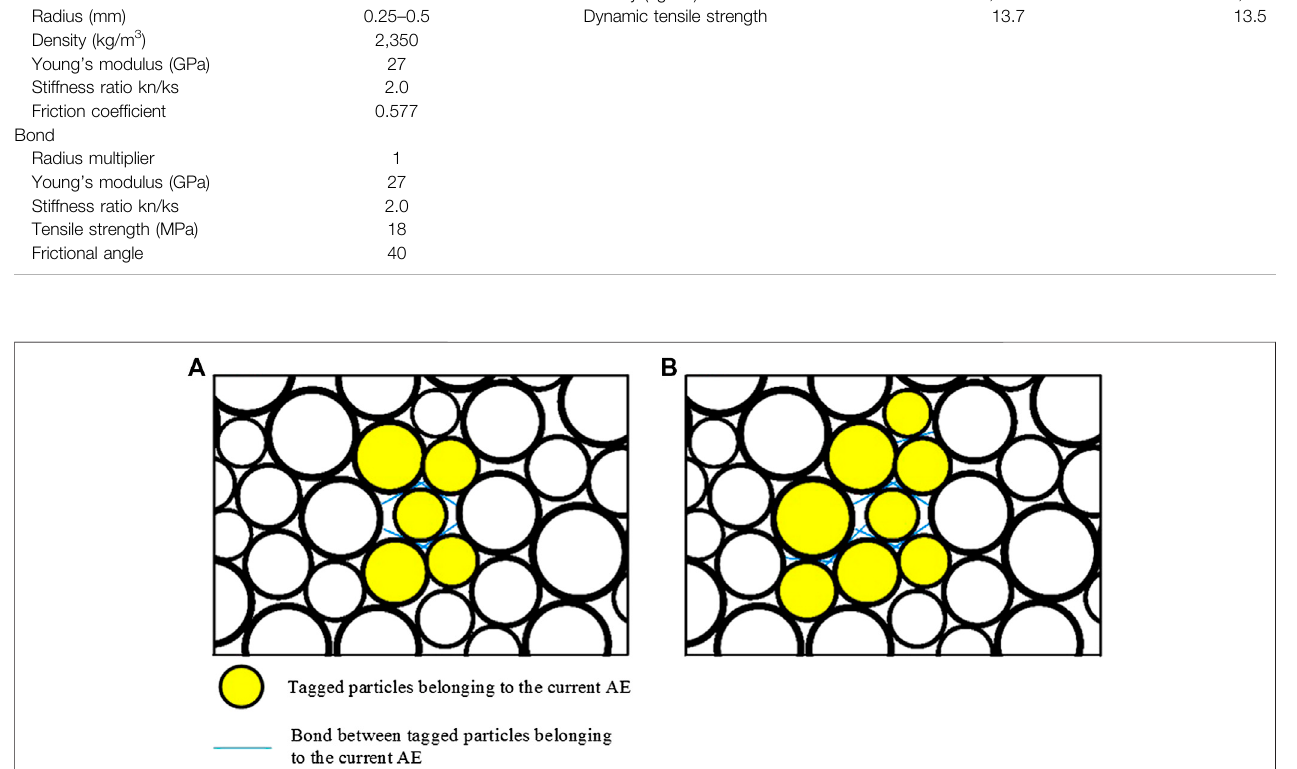
FIGURE 5 | An AE event generation process in this simulation. (A) is the start of an event and (B) is the fi nish state of this event.